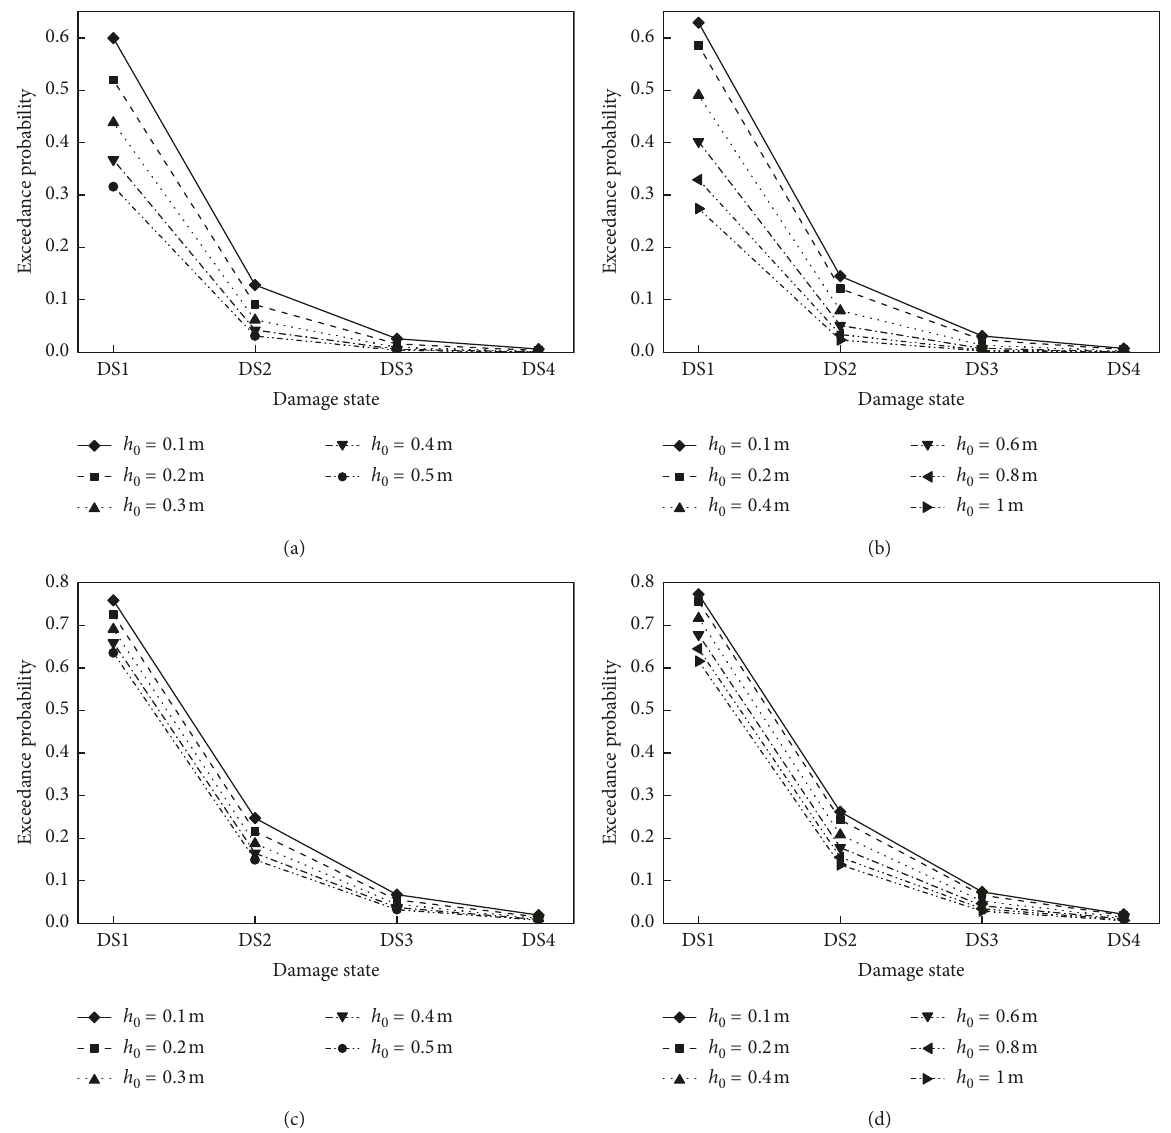
Figure 7: Structural peak acceleration when K and DS4 are defined by the structural peak acceleration in Table 2). (a) μ 0 . 0m, C h 1 (cid:31) 1